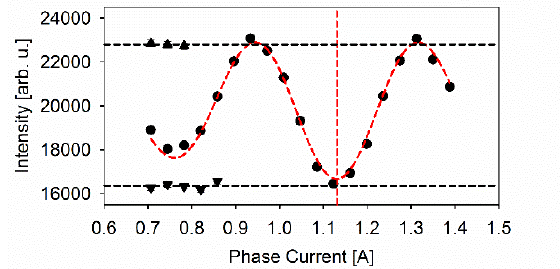
Fig. 1. Illustration of the standard measurement of the neutron spin-echo amplitude at a given